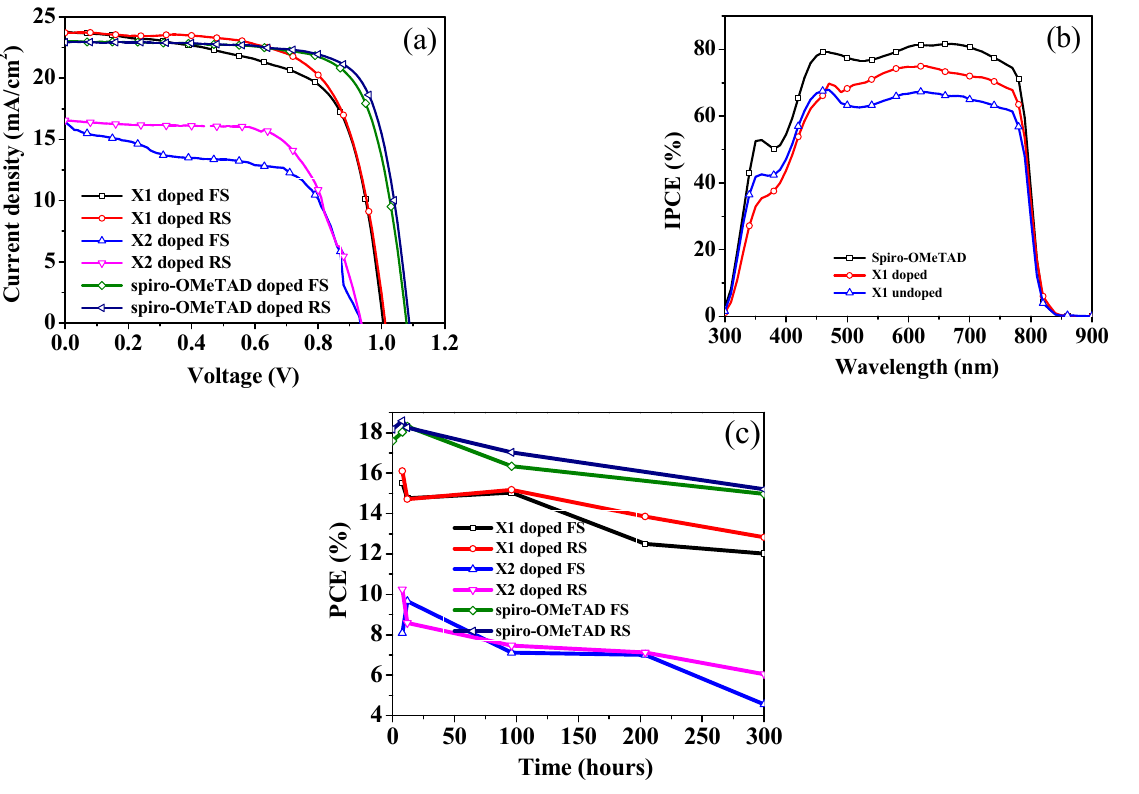
Figure 8. Device architecture ITO/compact SnO 2 /perovskite (Cs 0.05 MA 0.2 FA 0.75 Pb(Br 0.05 I 0.95 ) 3 )/HTM ( X1 , X2 )/Ag.